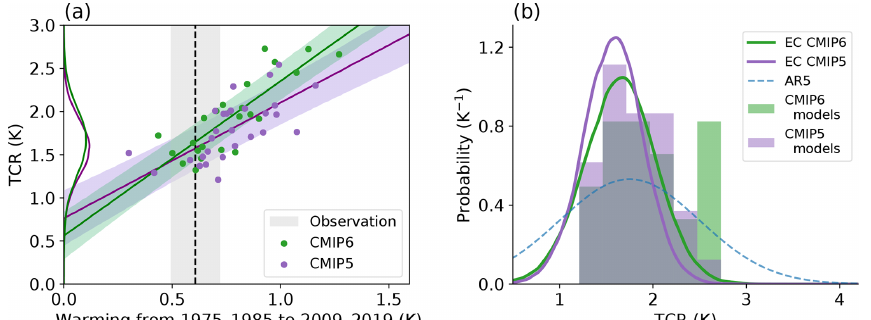
Figure 4. (a) Emergent constraint on TCR against historical warming (cid:49)T . (cid:49)T is calculated from the difference between 1975–1985 and 2009–2019 of a time series of GMSAT. Linear regression is performed with all CMIP5 and CMIP6 simulations. Shaded areas indicate a 90% prediction interval (see Appendix A). The vertical dashed line is the mean value of the observations, and the y axis shows the probability distribution of both generations of ensembles. (b) Comparison of probability distributions for the transient climate response using post-1975 warming using CMIP5 and CMIP6 simulations. The probability distribution in the fifth IPCC assessment is not fully specified, so the figure shows a normal distribution with the same likely range as